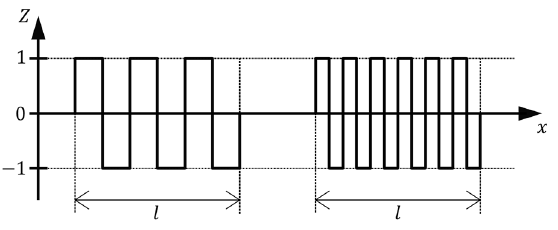
Figure 2. Two lines with different surface characteristics but same result for R